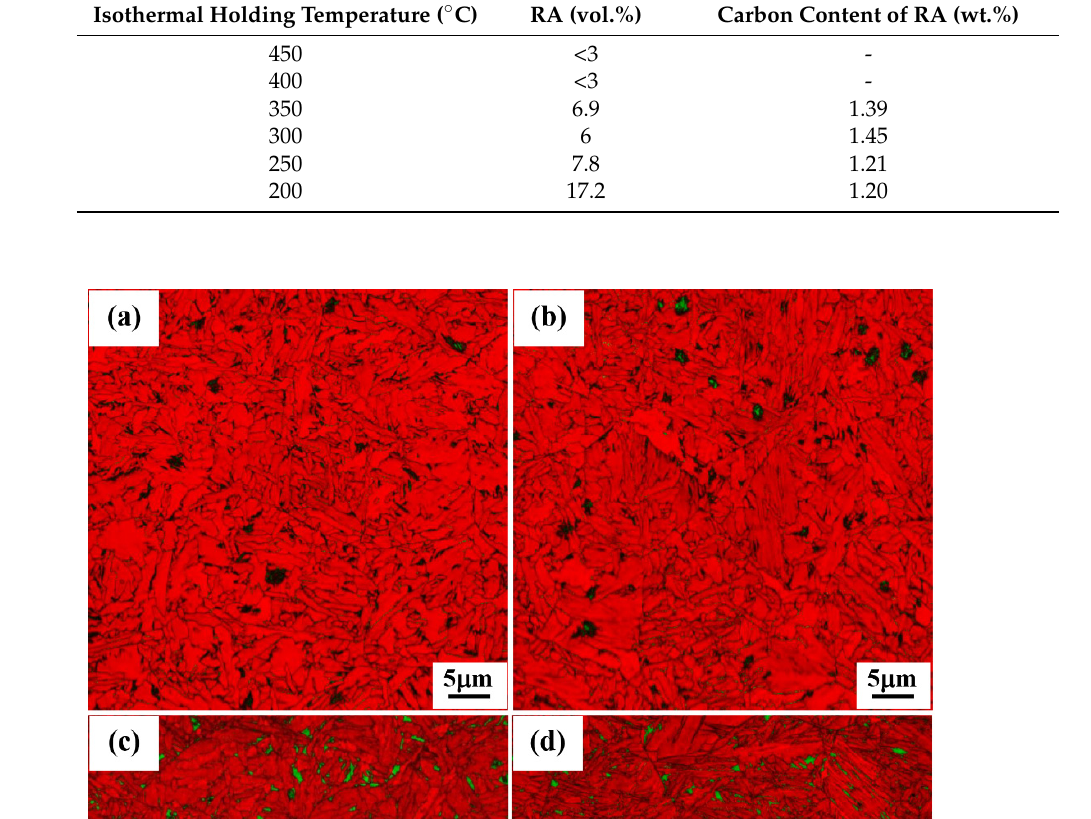
Table 4. The average RA phase fractions and their carbon contents in the case of Q&B (450, 400, 350, 300 ◦ C) and Q&P (250, 200 ◦ C) specimens held for 1 h.